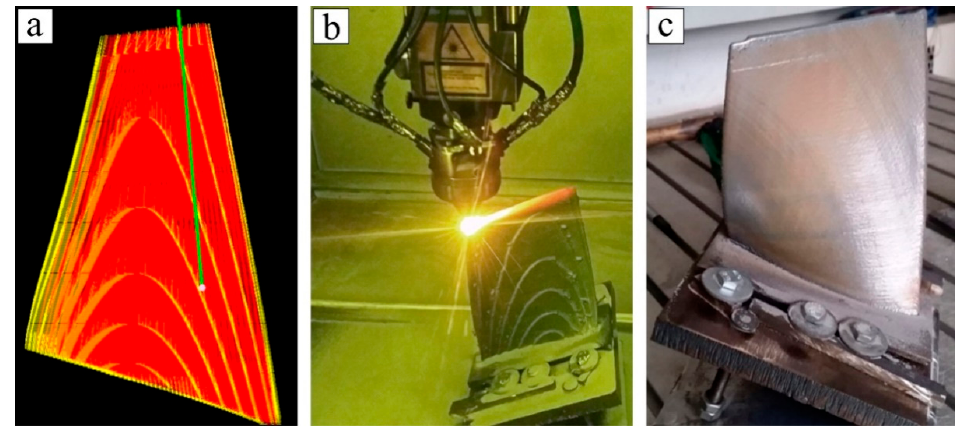
Figure 1. The blades of a gas turbine compressor; ( a ) the path generated in Additive Control; ( b ) the process of blade deposition; ( c ) for a Ti-Al-4V deposited blade.